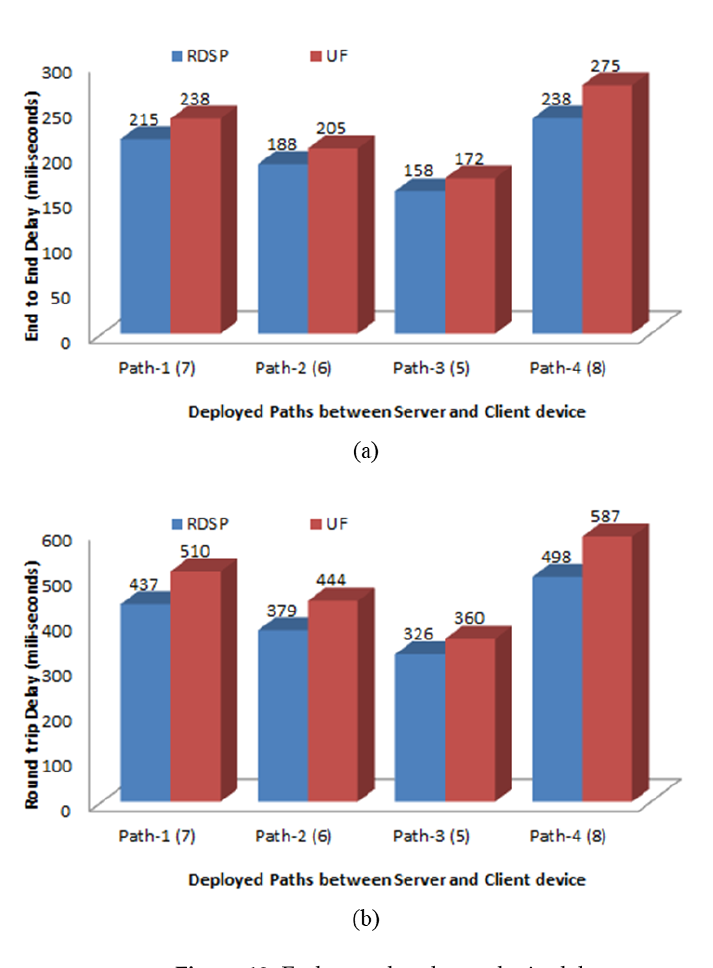
Figure 10. End-to-end and round-trip